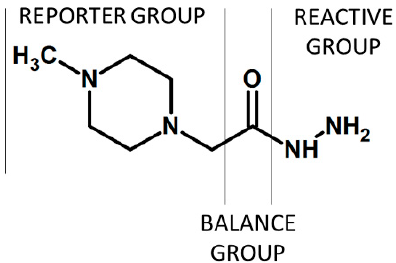
Figure 8. iTRAQ hydrazide (iTRAQH) proposed by Palmese et al. [12].